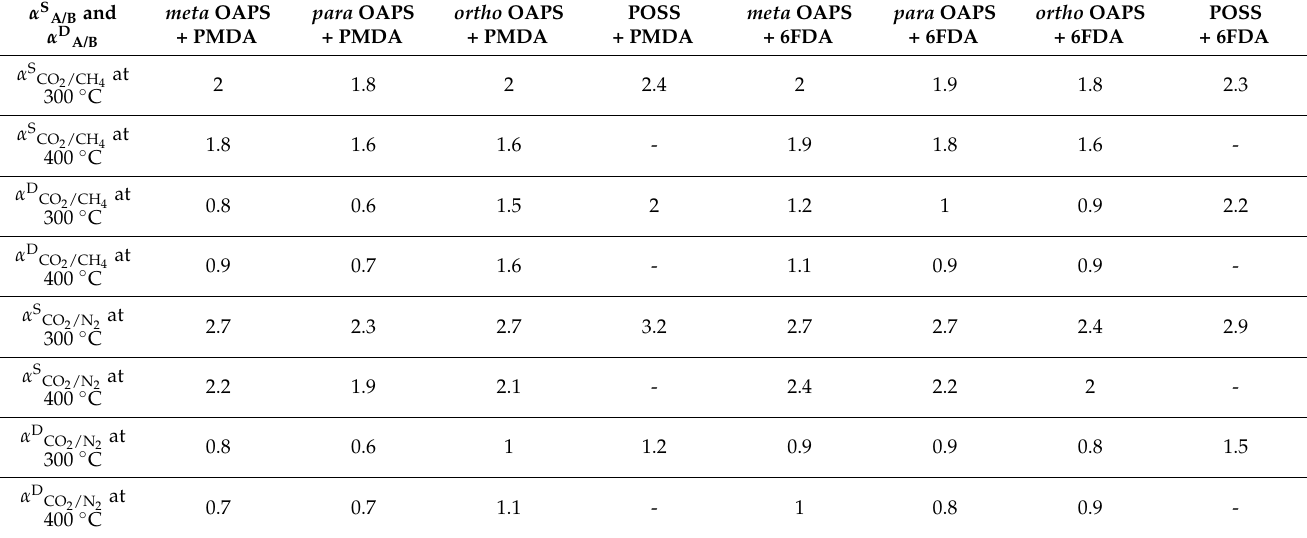
Table 5. Ideal solubility and diffusion selectivities for the CO 2 /CH 4 and CO 2 /N 2 gas pairs in the polyOAPS/POSS-imides at both 300 ◦ C and 400 ◦ C and at 60 bar. The maximum standard error is less than 0.1 for all the